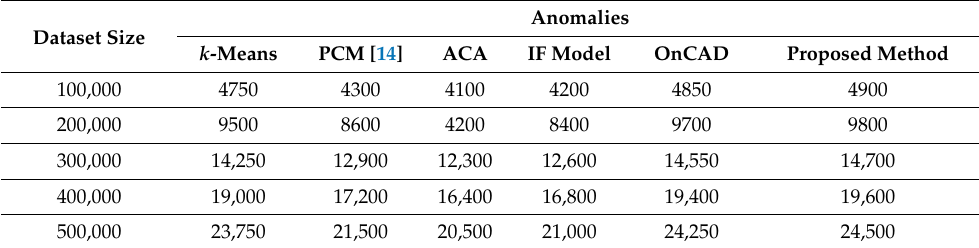
Figure 2. Comparative analysis of output clusters using KDDCUP’99. Table 6. Comparative analysis of anomalies using